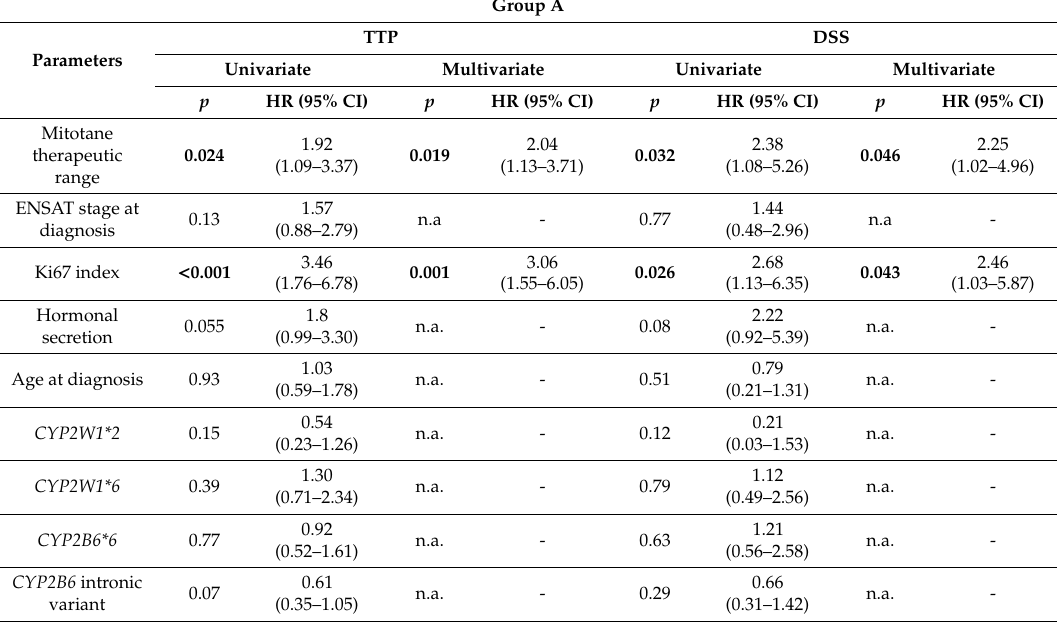
Table 2. Univariate and multivariate analysis correlating clinical and histopathological parameters and the investigated SNPs with response to mitotane treatment and disease-specific survival in group A ( n = 103). Group A TTP DSS Parameters Univariate Multivariate Univariate